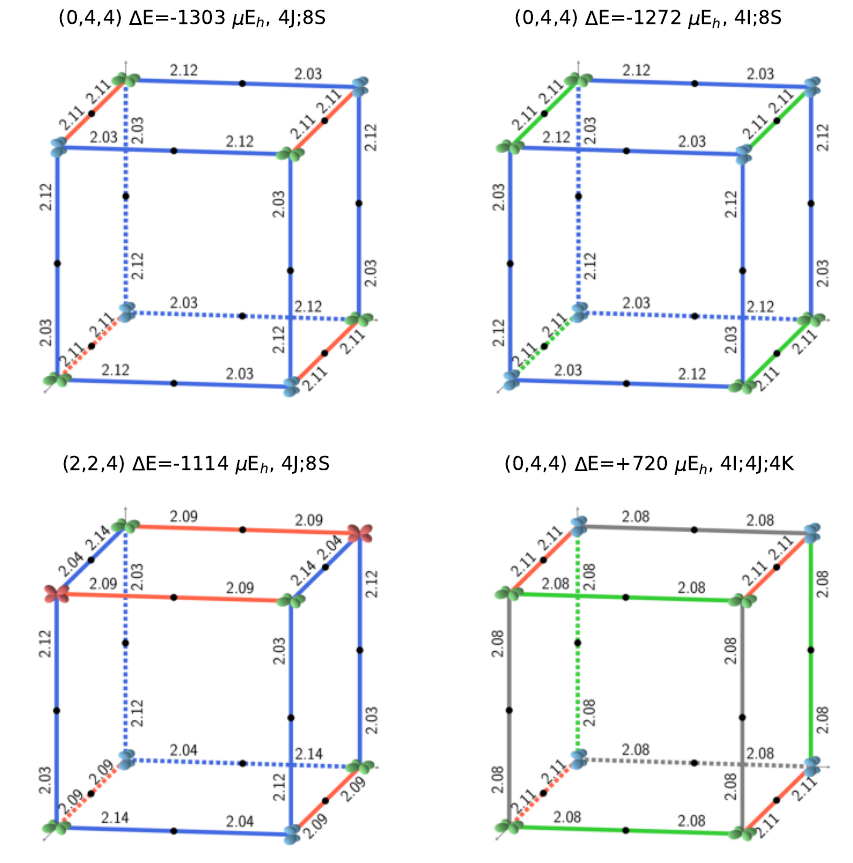
Figure 1. The three most stable and the least stable ( bottom right ) SICs. B3LYP AFM energies refer to two formula units. The doubly occupied d orbital on Fe is shown; red, blue, and green indicate d yz , d xz and d xy , respectively. The relative orientation of the d orbitals or interactions are indicated as colored edges: blue: S, green: I, red: J, and gray: K. Half the number of interactions in the corresponding S222 cell present in each case is summarized above the cube (for example 4J;8S for the 12 edges of the top left cube), together with the CEC (class of equivalent composition), ∆ E and ∆ V . The corresponding FM B3LYP energies are − 1549, − 1428, − 1373, and +593 µ E h , respectively. The four configurations can be described with a smaller unit cell, with space groups Fmmm (N. 69, orthorhombic, 2 f.u.), Pnma (N. 62, orthorhombic, 4 f.u.), P42/mnm (N. 136, tetragonal, 4 f.u.), and Cmmm (N. 65, orthorhombic, 4 f.u.). The identification of the space group has been performed by using the spglib code